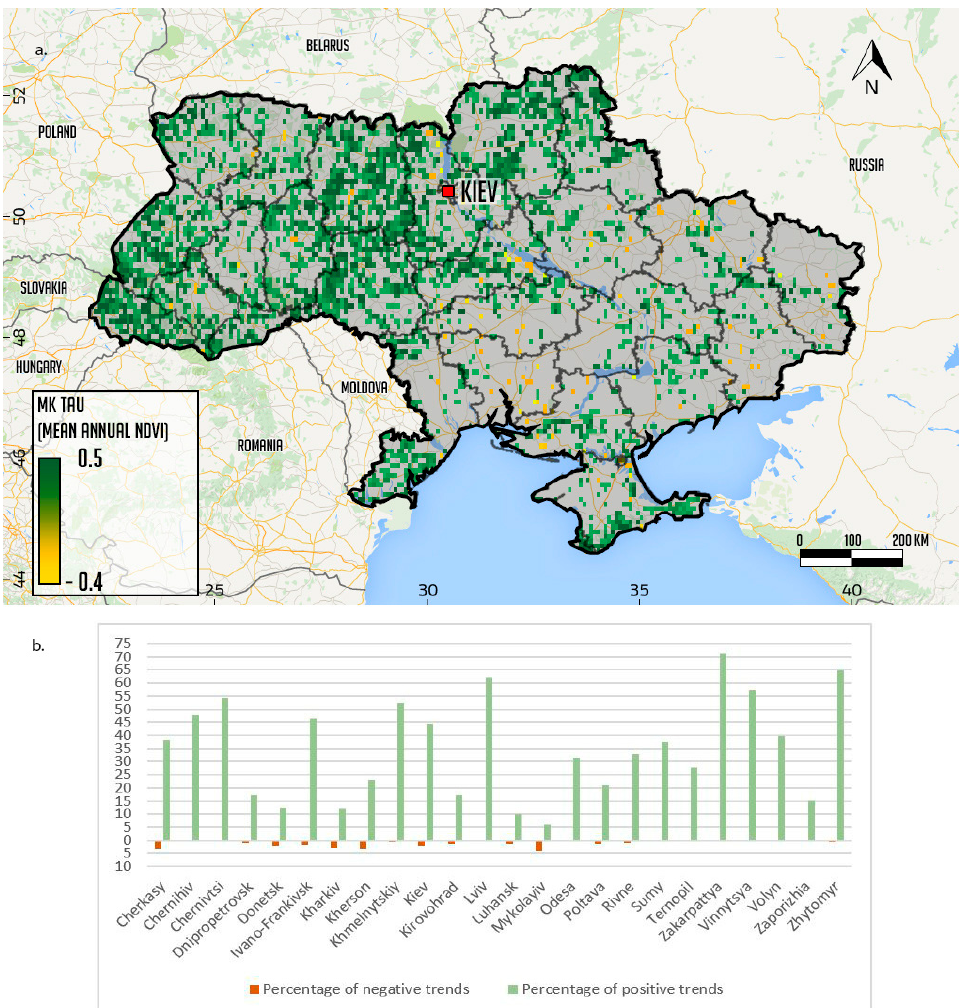
Figure 2. Spatial distribution of annually aggregated Normalized Difference Vegetation Index (NDVI) trends for the period 1982 to 2013 ( a ); and the areal statistics for each region (oblast) ( b ).